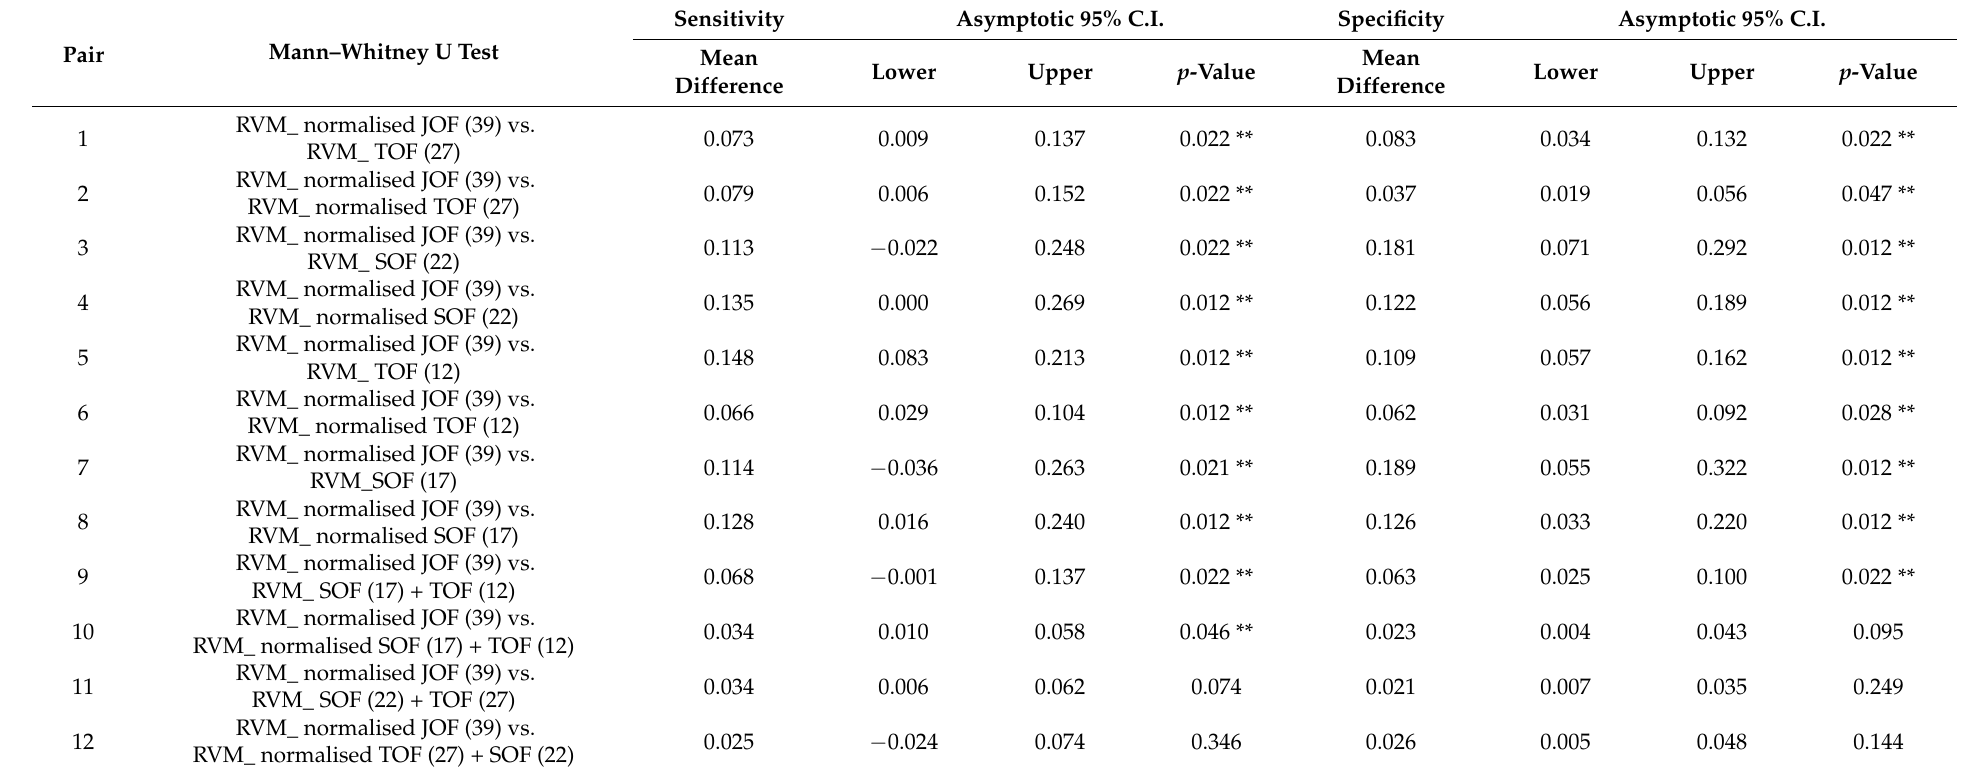
Table 3. Mann–Whitney U test of differences in sensitivity and specificity of classifiers on validation